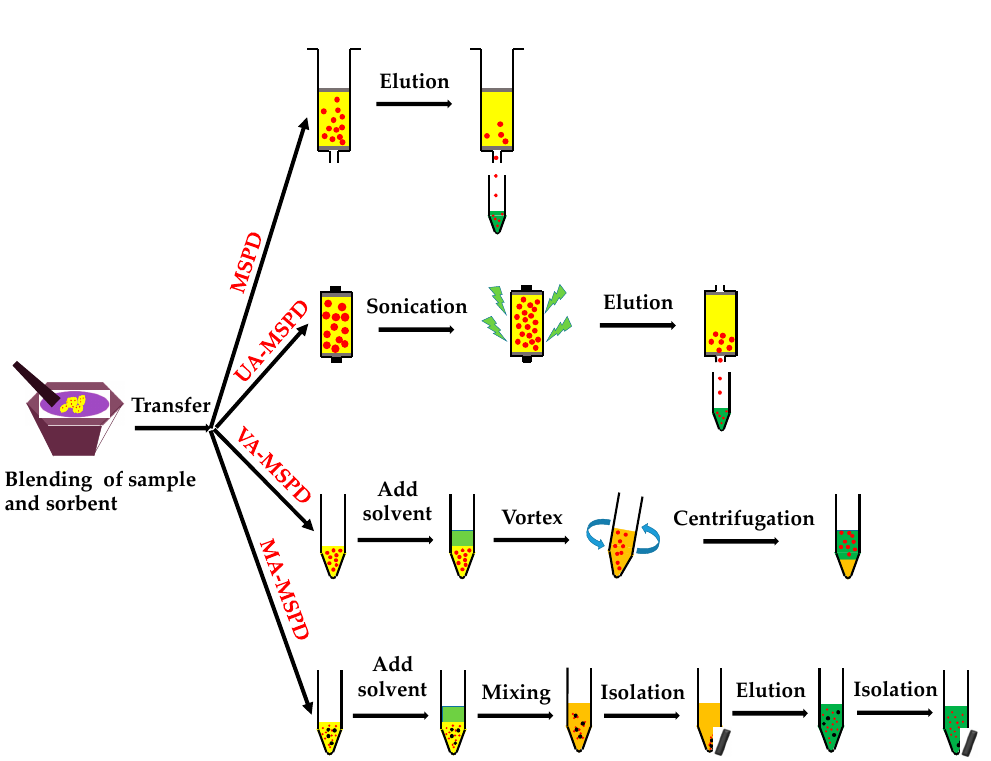
Figure 1. Schematic procedure of original matrix solid phase dispersion (MSPD), ultrasonic-assisted MSPD (UA-MSPD), vortex-assisted MSPD (VA-MSPD), and magnetically-assisted MSPD (MA-MSPD).